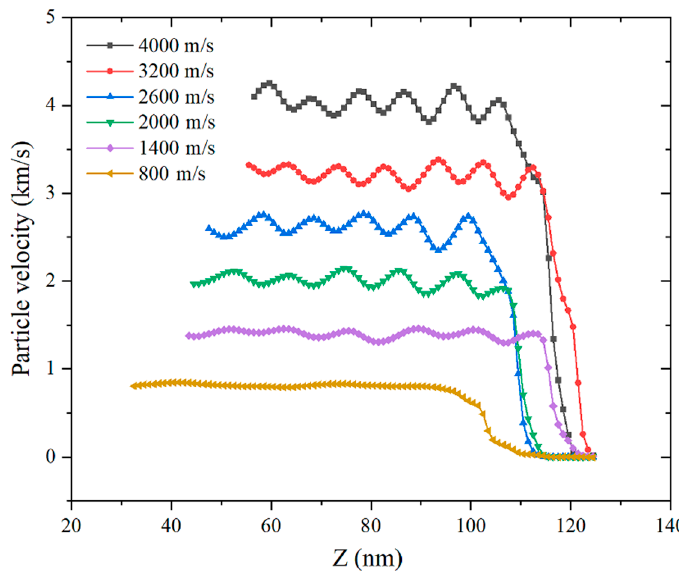
Figure 13. Comparison of particle velocities with different impact velocities.